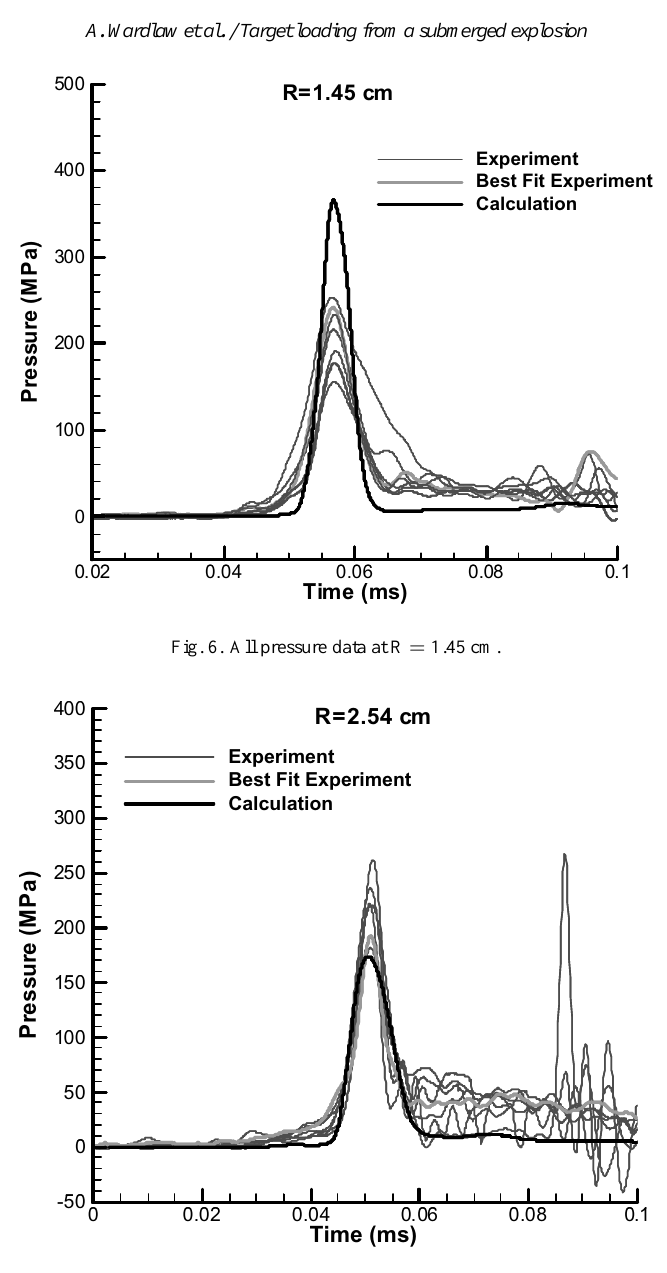
Fig. 7. Pressures at R = 2.54